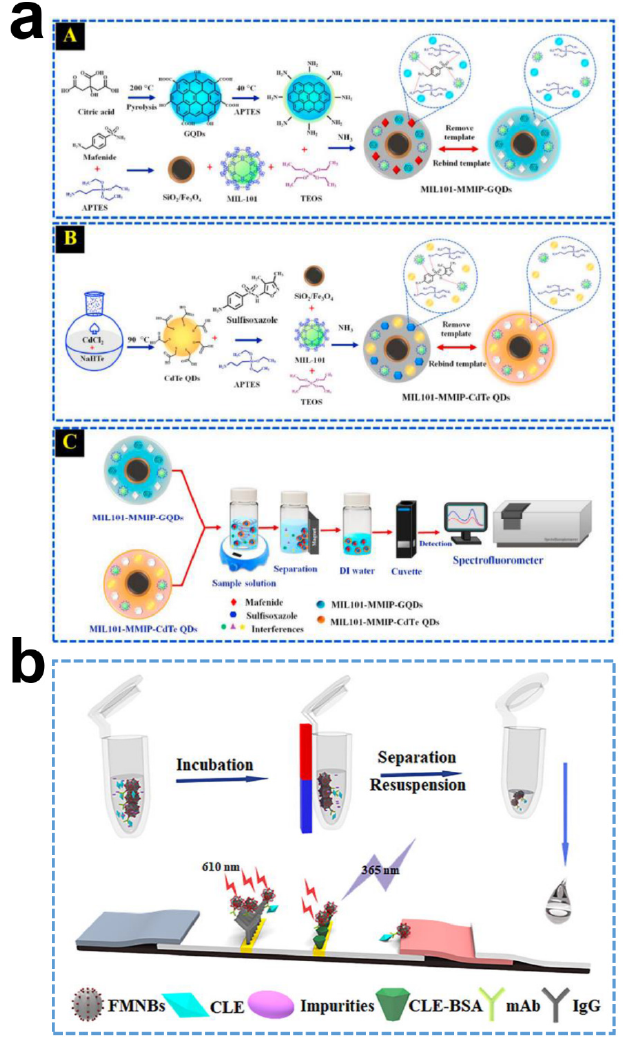
Figure 7. ( a ) Scheme shows the fabrication procedures of ( A ) MIL101-MMIPs-GQDs probe and ( B ) MIL101-MMIP-CdTe QDs probe, ( C ) and their applications in simultaneous detection of mafenide and sulfsoxazole using the two nanohybrid optosensing probe. Reproduced with permission from [163]. 2021, Copyright Microchemical Journal; ( b ) Schematic illustration of bifunctional LFIA sensor integrate the process of sample pretreatment and rapid detection of clenbuterol in swine urine. Re- produced with permission from [166]. 2019, Copyright Journal of Agricultural Food Chemistry. Table 4. Detection performances of MNPs@QDs-based sensors for pesticides, antibiotics, and illegal additives. Analytes